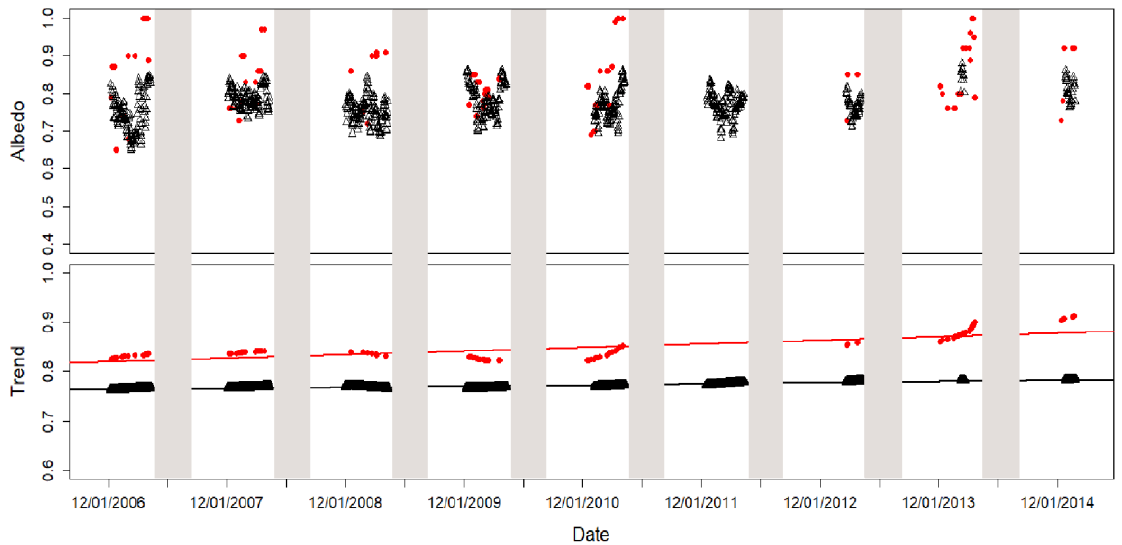
Figure 10. Moving average of in-situ albedo (open triangles) and maximum values of MOD10A1 albedo (red dots) from December 1 to April 10 (upper figure) and the calculated trends of in-situ moving average (open triangles) and MOD10A1 maximum albedo (red dots) from December 1 to April 10 (bottom figure). The linear fits of the trend are also shown. The shaded areas correspond to dates from April 10 to September 1 each year.